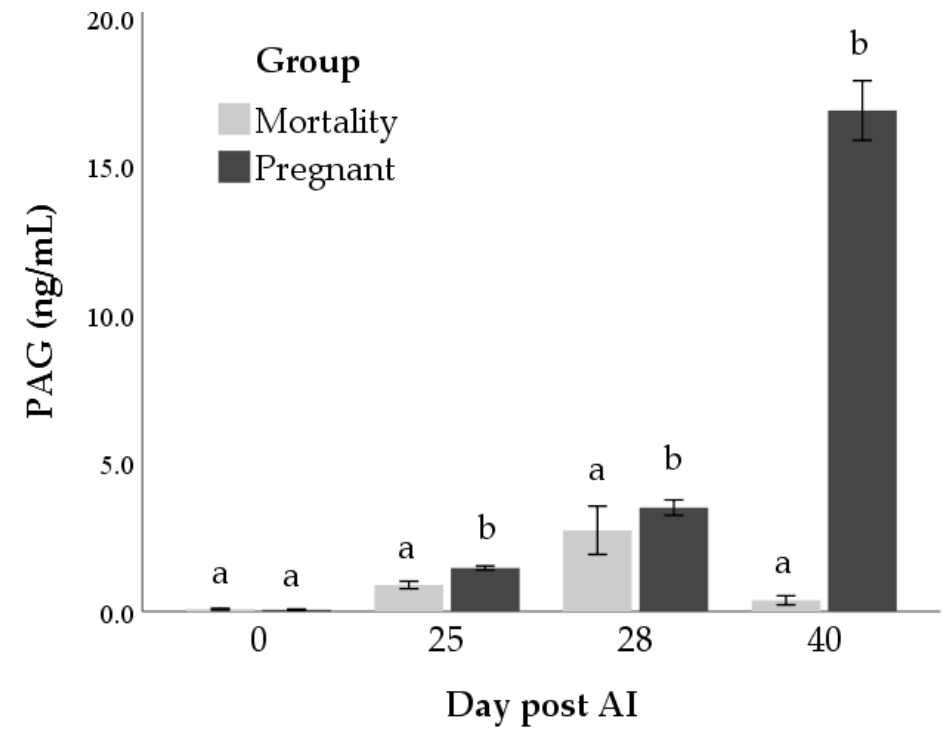
Figure 3. Concentrations of pregnancy-associated glycoproteins (PAG) in mortality and pregnant groups at days 0, 25, 28, and 40 post-AI. Bars not sharing the same superscript within each day are significantly different at p < 0.05.